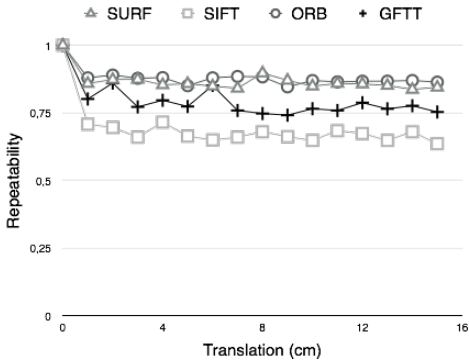
Figure 8: Repeatability of the detectors for several translations